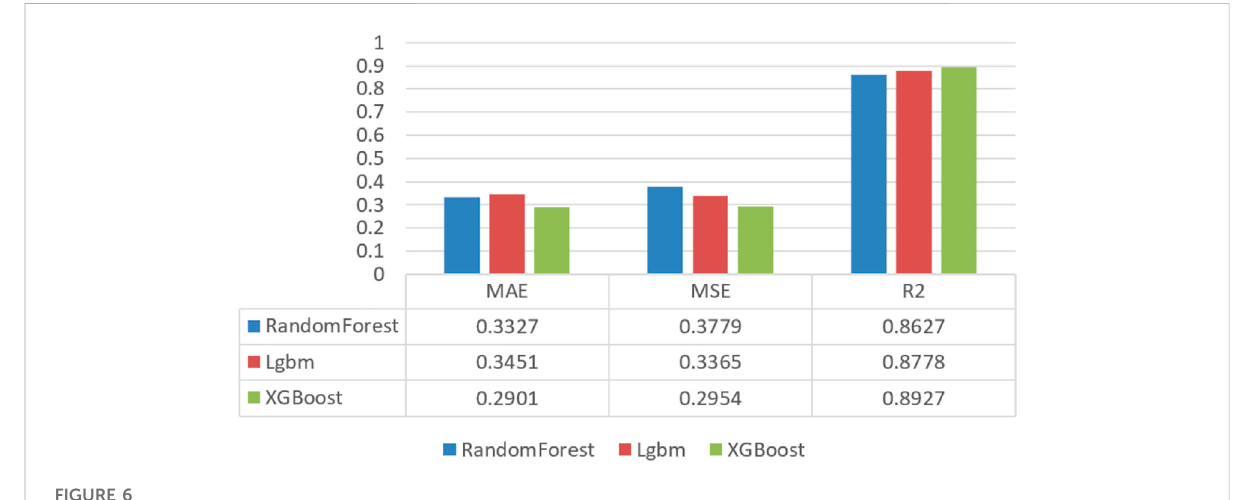
FIGURE 6 Evaluate metric of three regression models.